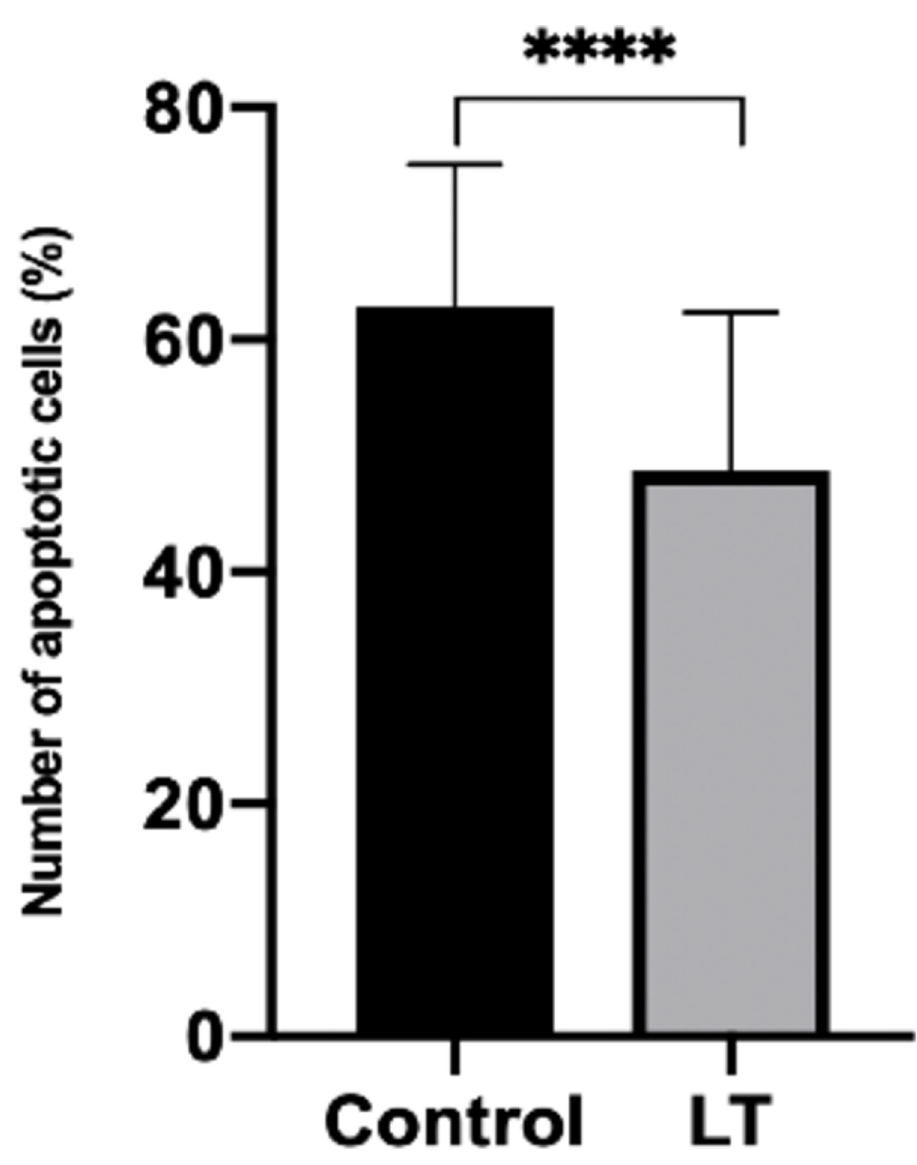
Fig 3. Initial observed effect in the reduction of cell loss to apoptosis. LT = light therapy (PBM). ���� denotes P < 0.0001, error bars represent standard deviation